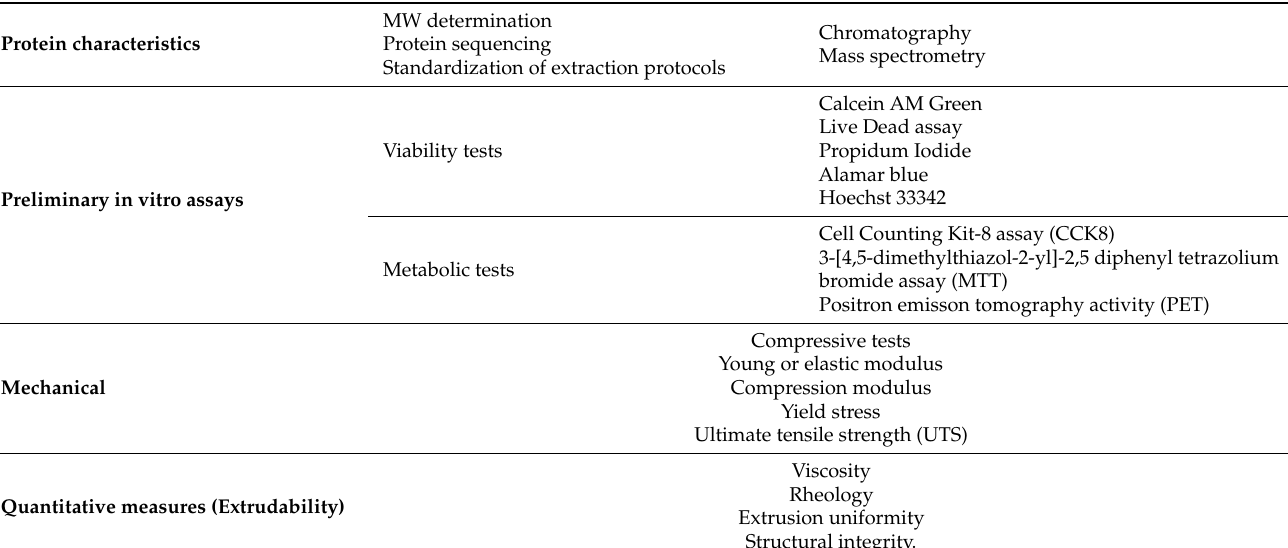
Table 2. Preprocessing parameters to consider throughout the development of bioink formulations and examples of possible generic characterization